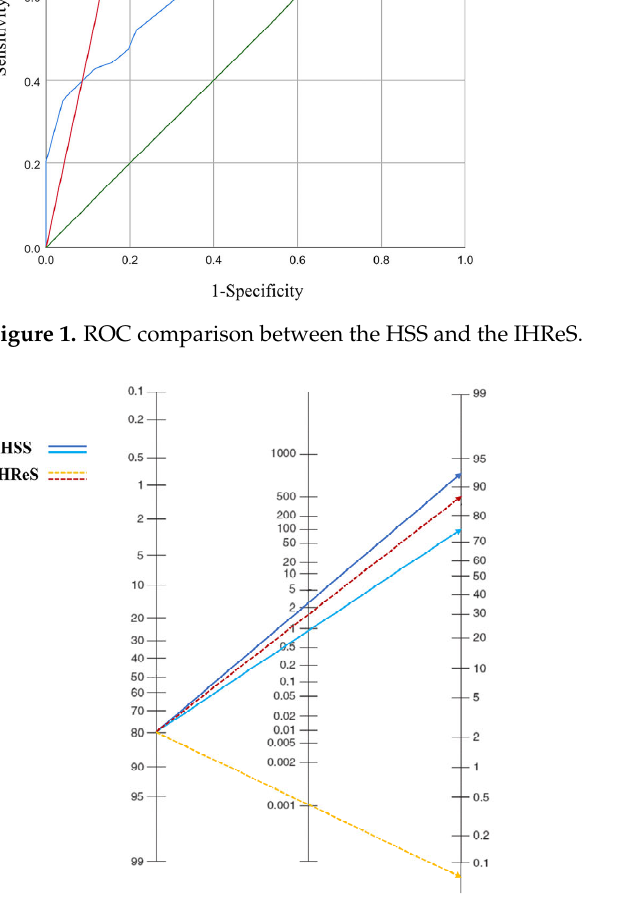
Figure 2. Fagan nomogram of the HSS and the IHReS. When the pre-test probability was 80.8%, the dark blue solid line indicated that the post-test probability of +LR was 92.3%, while the light blue solid line indicated that the post-test probability of − LR was 75.0% when using the HSS. The red dotted line indicated that the post-test probability of +LR was 88.5%, while the yellow dotted line indicated that the post-test probability of − LR was 0.0% when using the